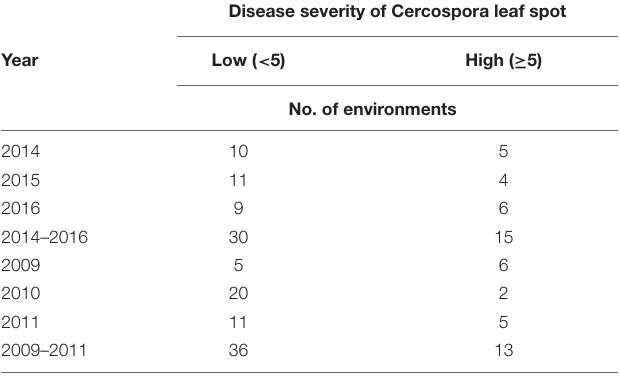
disease pressure, the effect of variety significantly increased from 1.6% under healthy conditions at low CLS infection to 4.0% in the non-treated level at high infection. Similarly, the environment × variety interaction increased from 0.0 to 3.8%. Under low infection, mean WSY across varieties was 15.59 t ha − 1 in the non-treated and 16.12 t ha − 1 in the healthy level ( Figure 1A ). The difference between the two fungicide levels ranged from 0.24 to 0.86 t ha − 1 among varieties. Changes in the